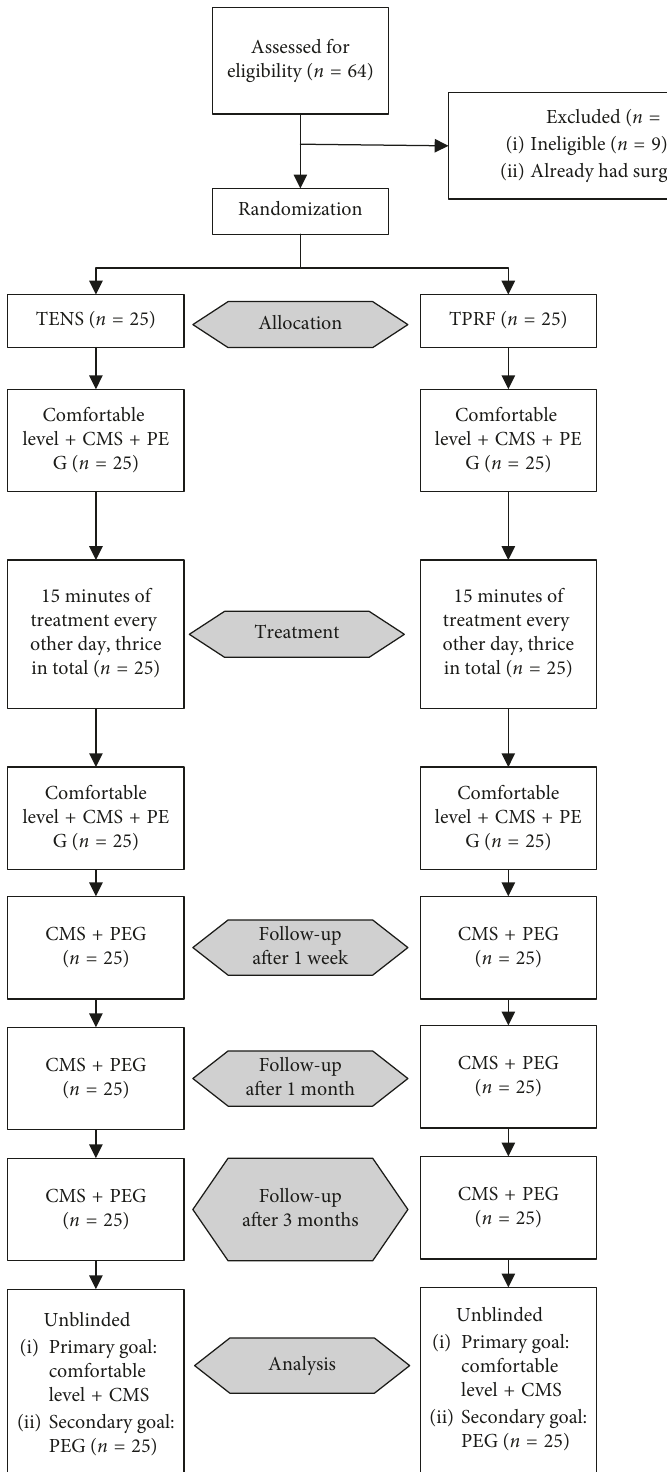
Figure 1: Flow diagram showing the sequence of randomization, blinding, treatments, data collection, and analysis. TENS electrical nerve stimulation; TPRF by visual analog score “VAS,” scored from 0 to 100), enjoyment of life, E (scored from 0 to 100), and general activity, G (scored from 0 to